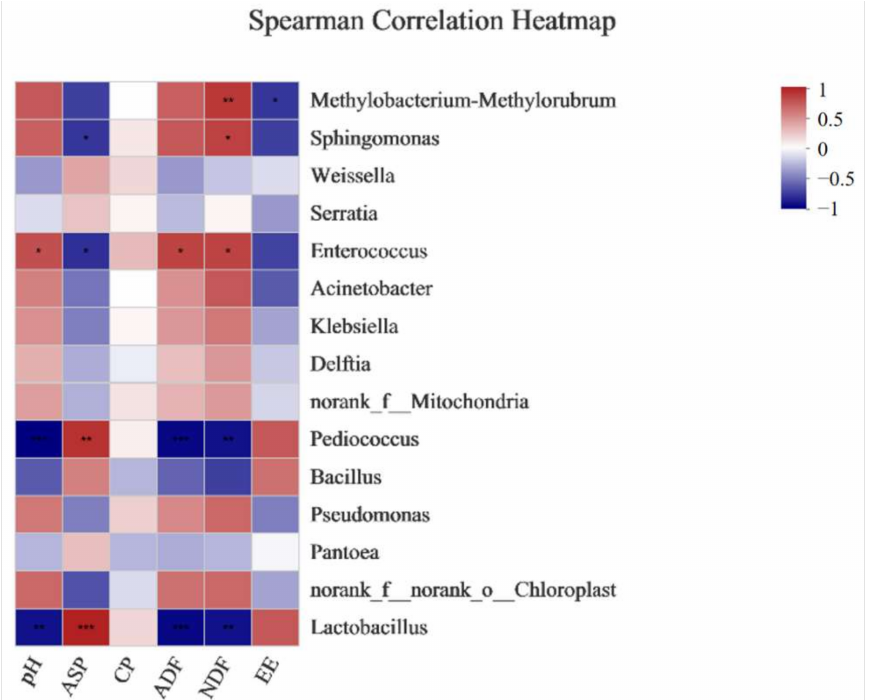
Figure 3. Correlation analyses between the chemical compositions and the top 15 tea residue mixture bacterial genera. The red squares show the positive correlations, while the blue squares show the negative correlations. * p ≤ 0.05; ** p ≤ 0.01; *** p ≤ 0.001. ASP = acid-soluble protein, CP = crude protein, ADF = acid detergent fiber, NDF = neutral detergent fiber, and EE = ether